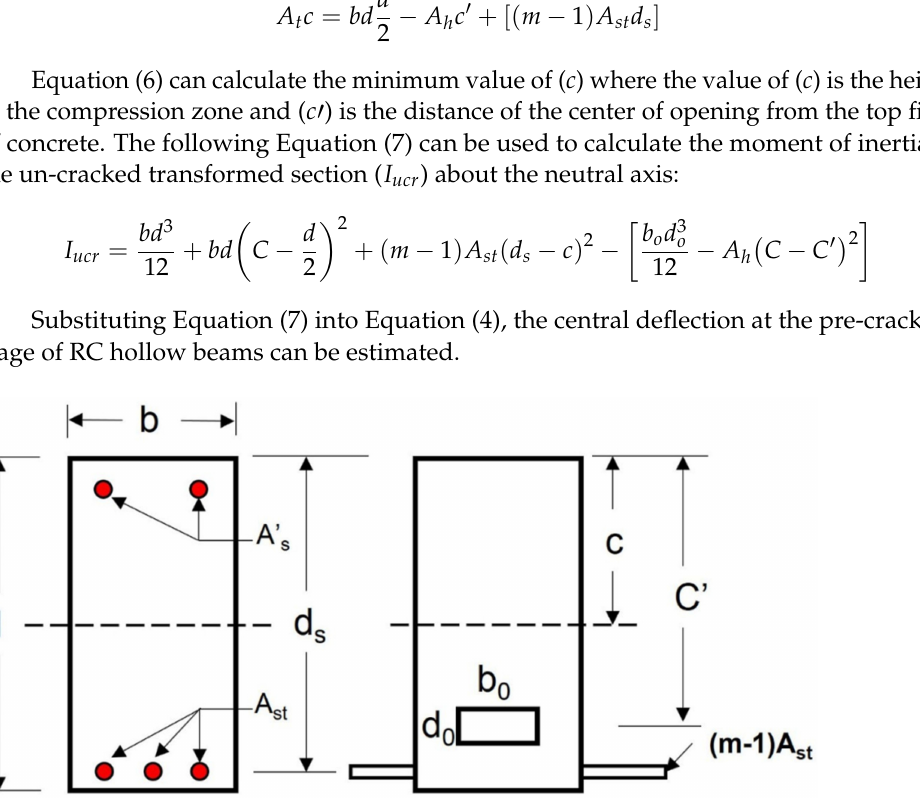
Figure 19. Transformed section of RC beam—before